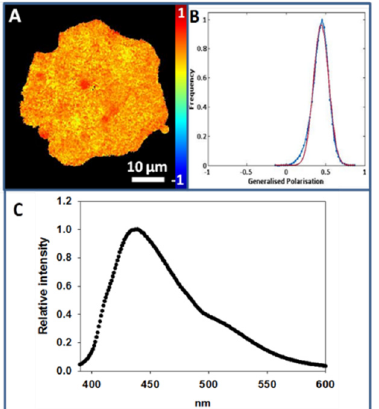
Figure 3. Laurdan staining of plasma membrane patches (at 20 °C). ( A ), Laurdan staining of a CHO cell plasma membrane patch. ( B ), Generalized polarization plot of image A. ( C ) Laurdan emission spectrum of CHO cell PM patches.